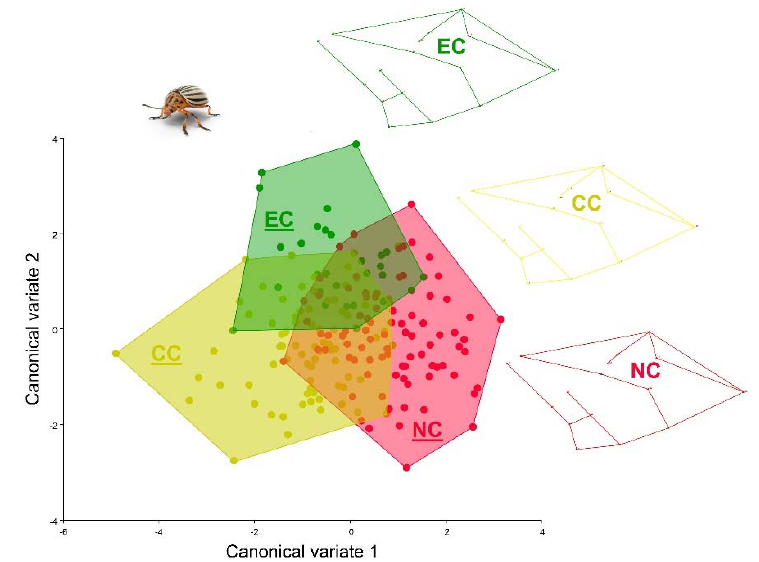
Figure 8. Canonical variate analysis of the Colorado potato beetle hindwing shape between populations from different regions of Croatia. CC: yellow, central Croatia; NC: red, north Croatia; EC: green, east Croatia.